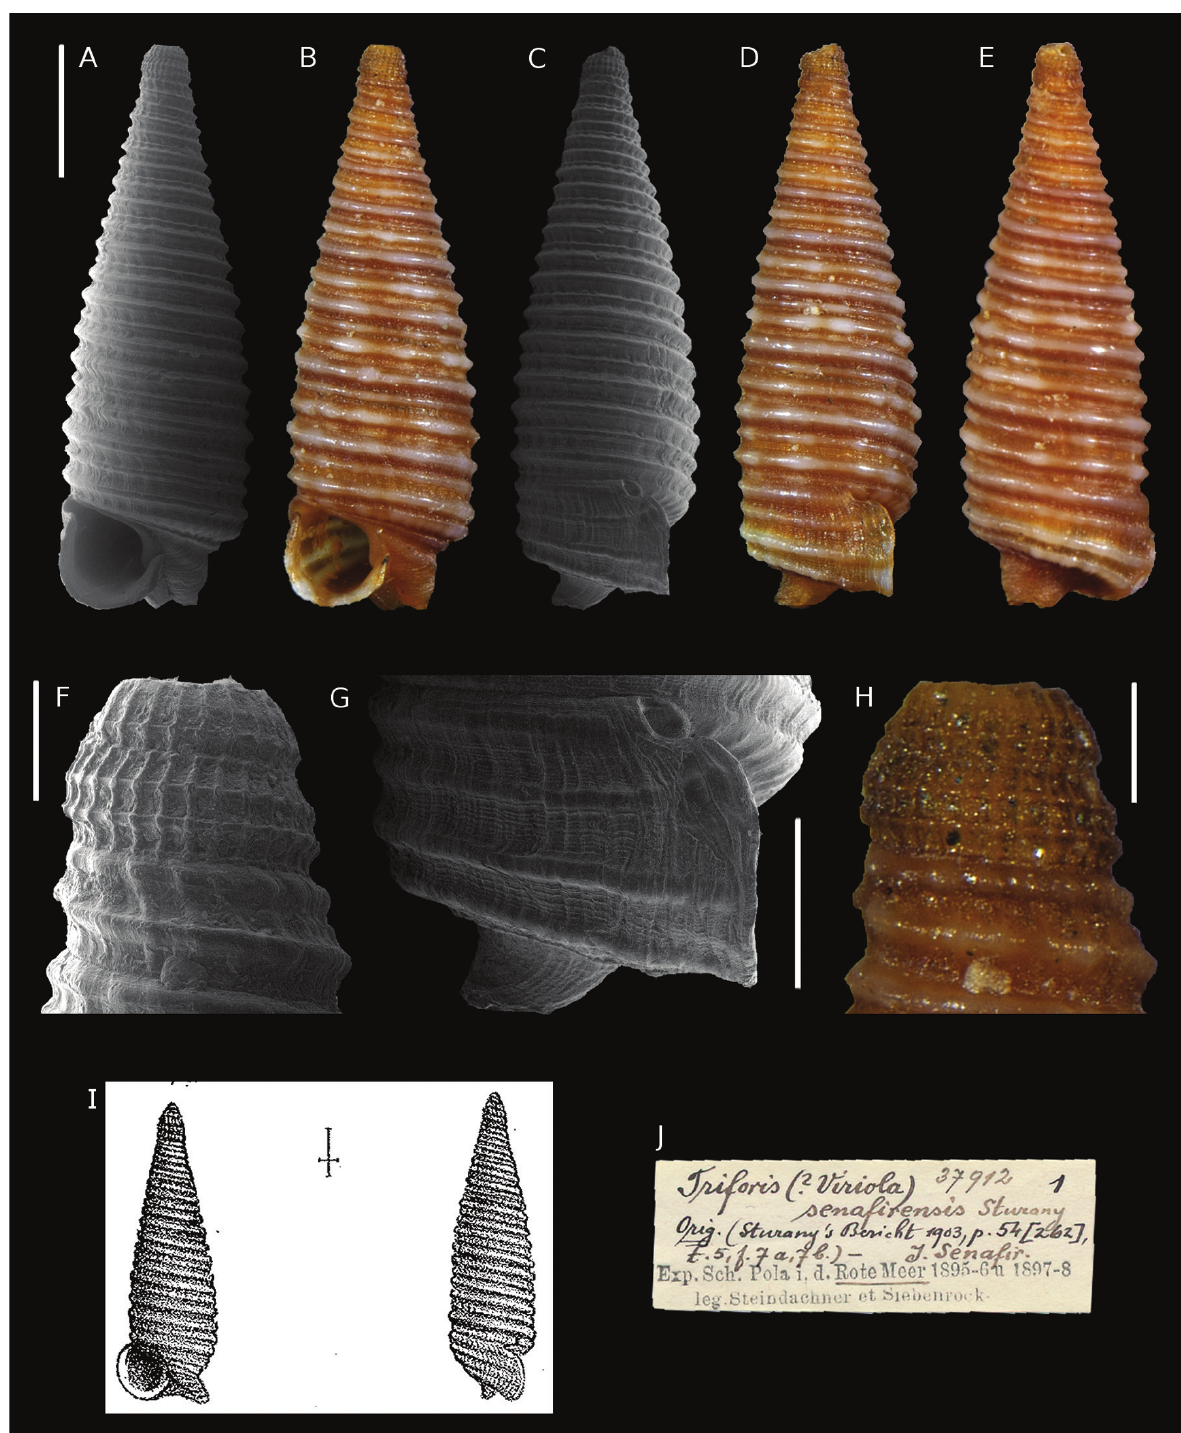
Figure 8. Triforis senafirensis Sturany, 1903, Locality 13 (Sanafir Island, Strait of Tiran, Northern Red Sea). A–H . Holotype, NHMW 37912: front ( A–B ), left side ( C–D ), back ( E ), protoconch ( F, H ), peristome ( G ). I . Original figure by Sturany (1903). J . Original holotype label. Scale bars: A–E : 1 mm, F , H : 0.2 mm, G : 0.5 mm. Höckerchen auf der Spindel. Translation. Shell fusiform, shiny, white, with traces of a yellow net pattern; of the eight whorls, the first two are milky white, smooth, teat-shaped, the following one and half has separated, pronounced and coarse axial ribs, the others almost smooth with the exception of the thread- like suture, the fine microscopic spiral sculpture,